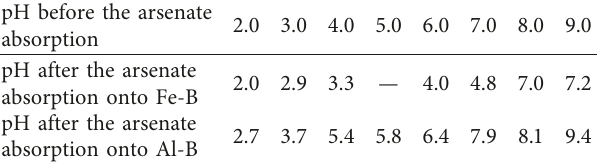
Figure 6: Point of zero charge plots of Fe-B (a) and Al-B Table 2: pH of As(V) solution before and after the arsenate ab- sorption onto Fe-B ( C o(As) � 12.98mg/L) and Al-B ( C o(As) � 16.84mg/L) ( T � 303K, m � 0.05g). pH before the arsenate